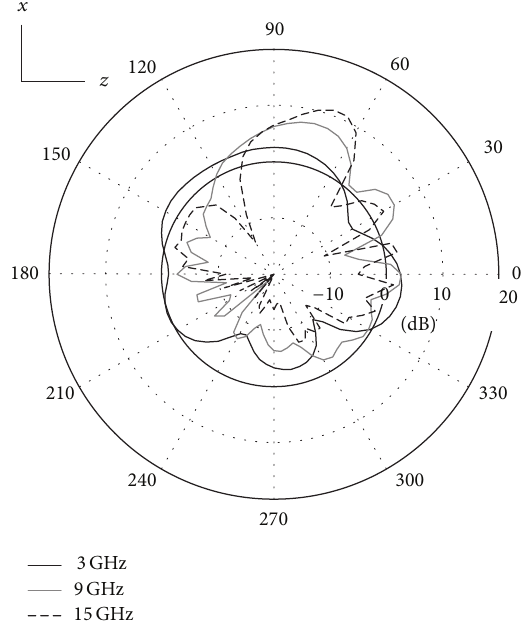
Figure 8: Radiation pattern of a conical antenna with elliptical aperture displaced of 40 mm in the xz